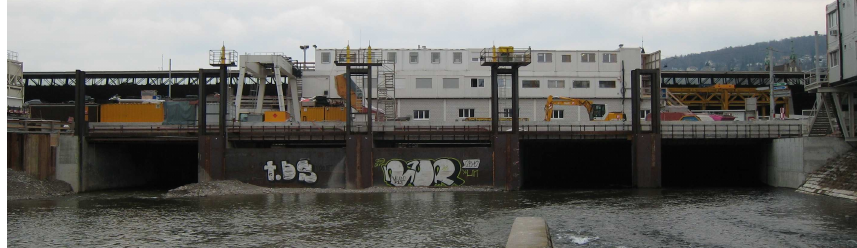
Fig. 2. The Sihl River flows beneath Zurich central railway station. Two of the five channels are sealed to provide dry conditions for the construction site located under the river level. The mean discharge on the day of the picture was 8.92m 3 s − 1 . Photo courtesy of A. Badoux,